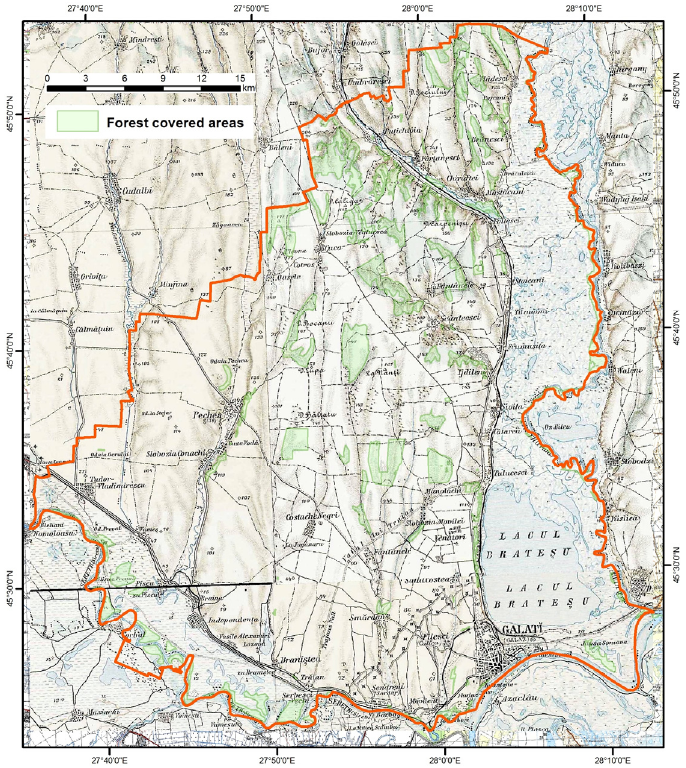
Figure 10. Forest-covered areas in 1912 (Austro-Hungarian Map).